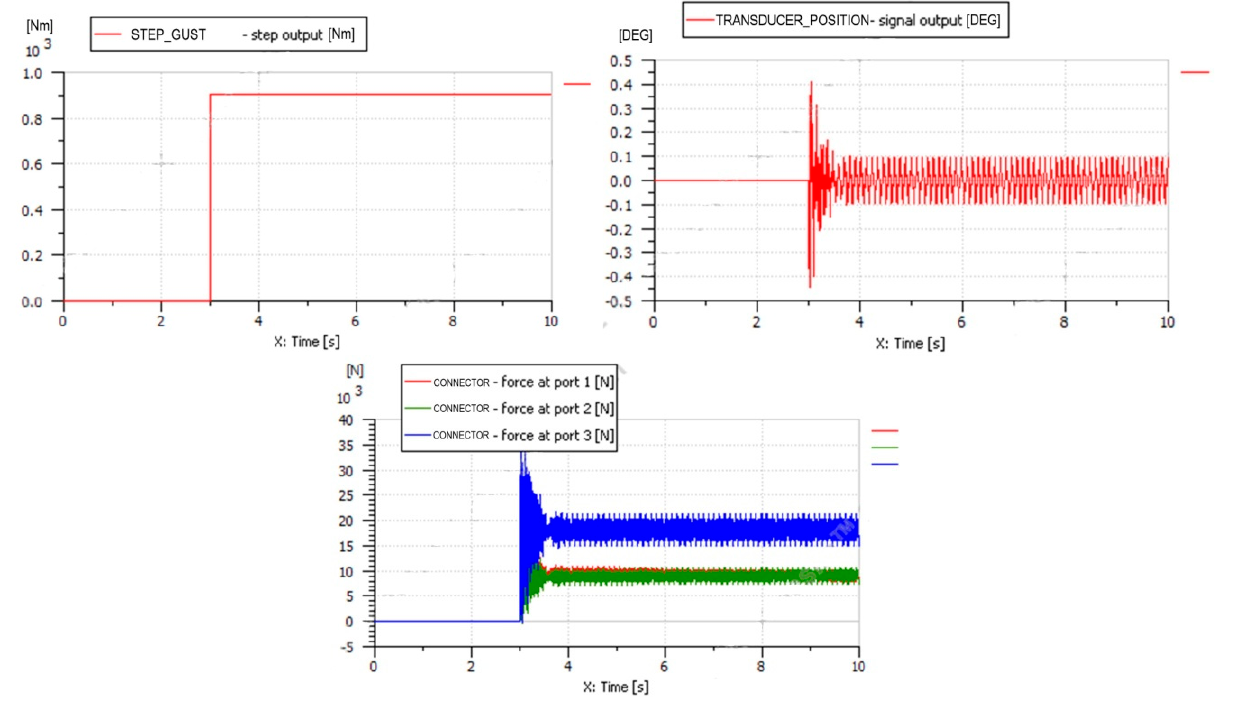
Figure 9. System behavior with step gust.